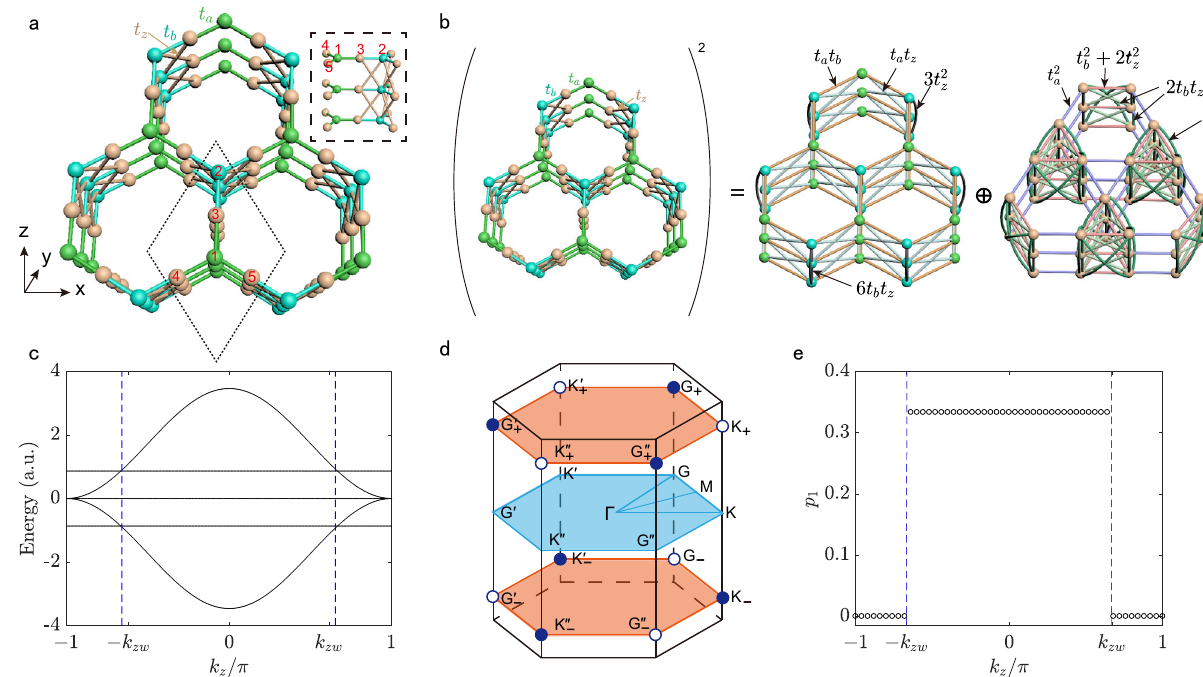
Fig. 1 | 3D stacked HK TB model. a Illustration of an in fi nite 3D stacked HK TB model. The unit cell including fi ve nodes is represented by the dashed black rhombus. The intralayer hoppings are t a (green) and t b (blue) in the x − y plane, whereas the interlayer double-helix hopping is t z (brown). Insets: Right view of the cell. b The equivalence between the squared Hamiltonian of the HK circuit and its